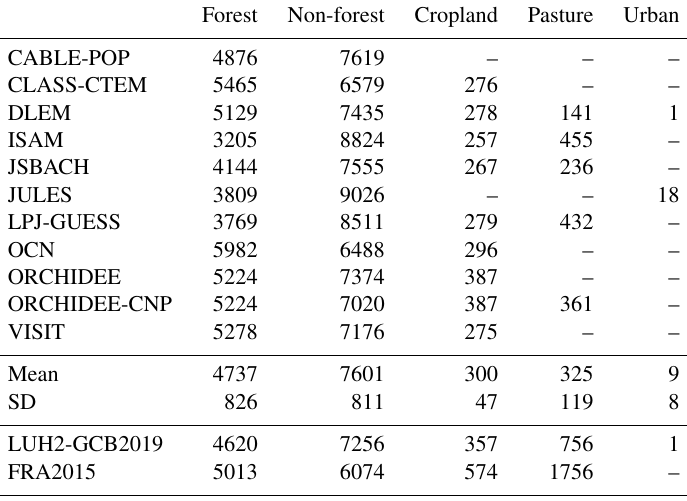
Table A2. Global preindustrial (1700) land cover (in Mha) in the GCB2018 DGVMs compared with that from our two main LULCC data